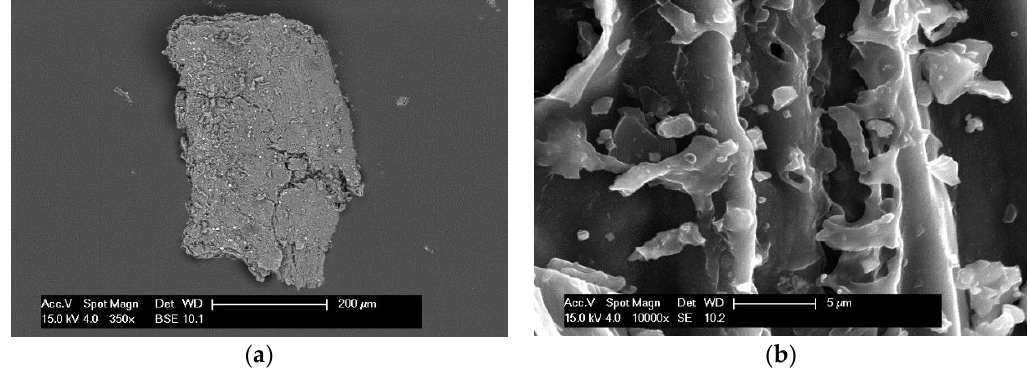
Figure 3. ( a ) SEM widefield image illustrating discrete biochar particle; ( b ) SEM close-up image (10,000×) does not reveal the presence of mesopores.